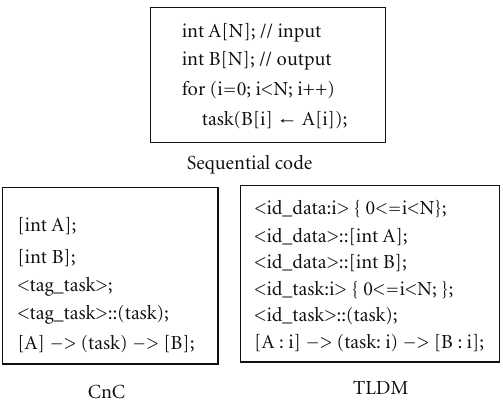
Figure 12: TLDM versus CnC: iterator domain and access pattern are explicitly specified in